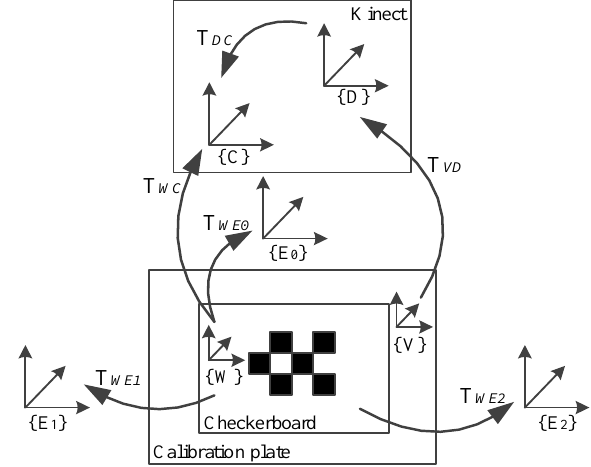
Figure 4. Reference frames and transformations. {D}, {C} and ({E0}, {E1}, {E2}) are the coordinate systems of depth, color, and external cameras, respectively.